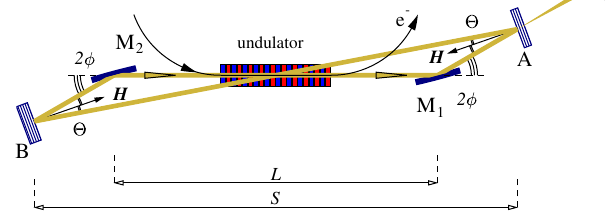
FIG. 2. (Color) Similar to the x-ray cavity in Fig. 1, but, with two mirrors: M 1 collimates the x-ray beam, while M 2 focuses x rays onto the electron bunch e (cid:1) in the undulator. This cavity configuration has also a very restricted range of tunability because of the small grazing angle of incidence (cid:4) ’ 1 mrad .